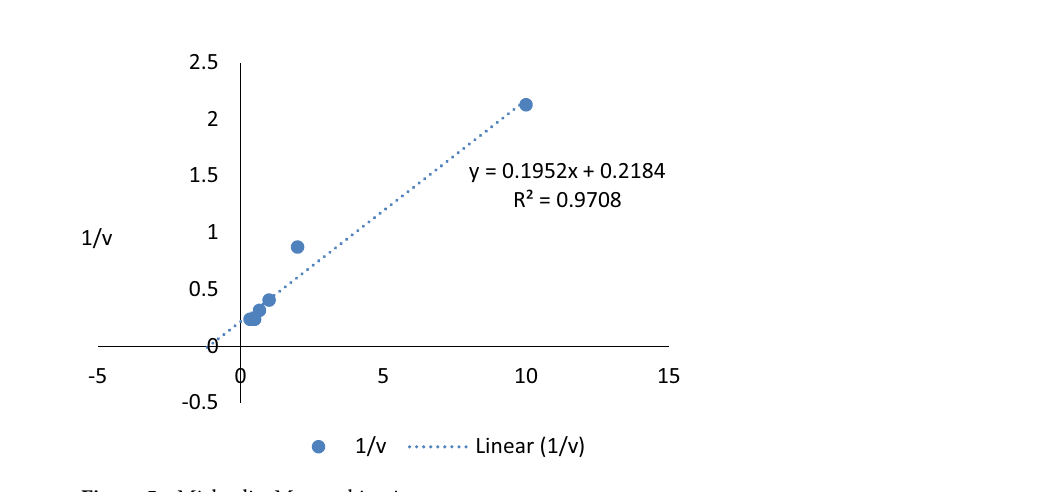
Figure 5. Michaelis–Menten kinetics.